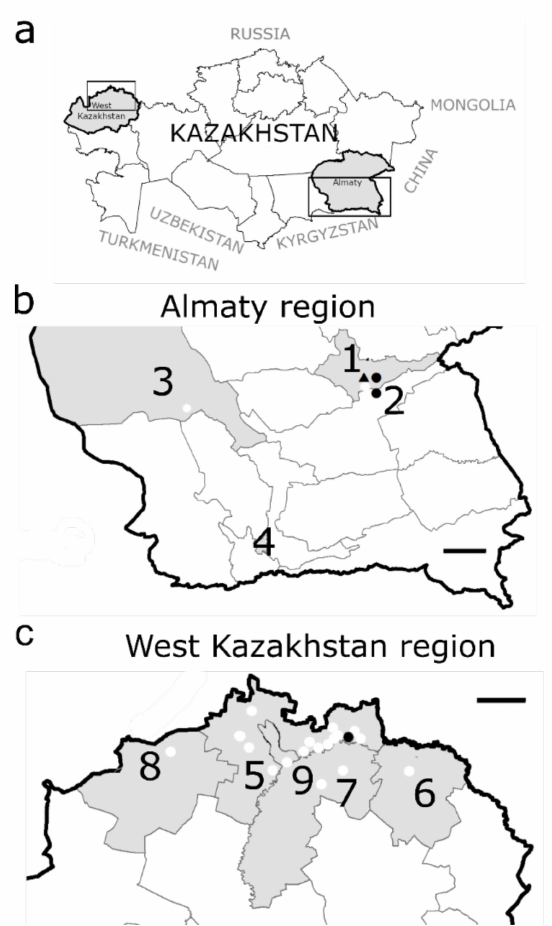
Figure 1. Geographical location of the sampling points for small mammals in